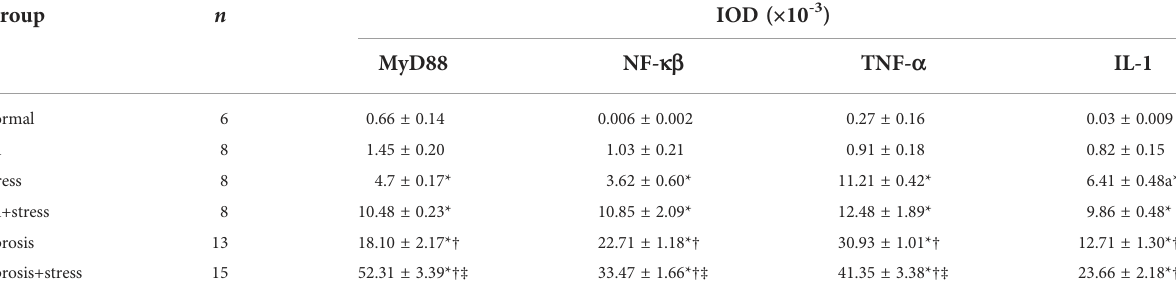
TABLE 3 Semi-quantitative analysis (IOD) of signaling protein expressions in LPS-TLR4 pathway depend on MyD88 in liver tissue (means ± SD).